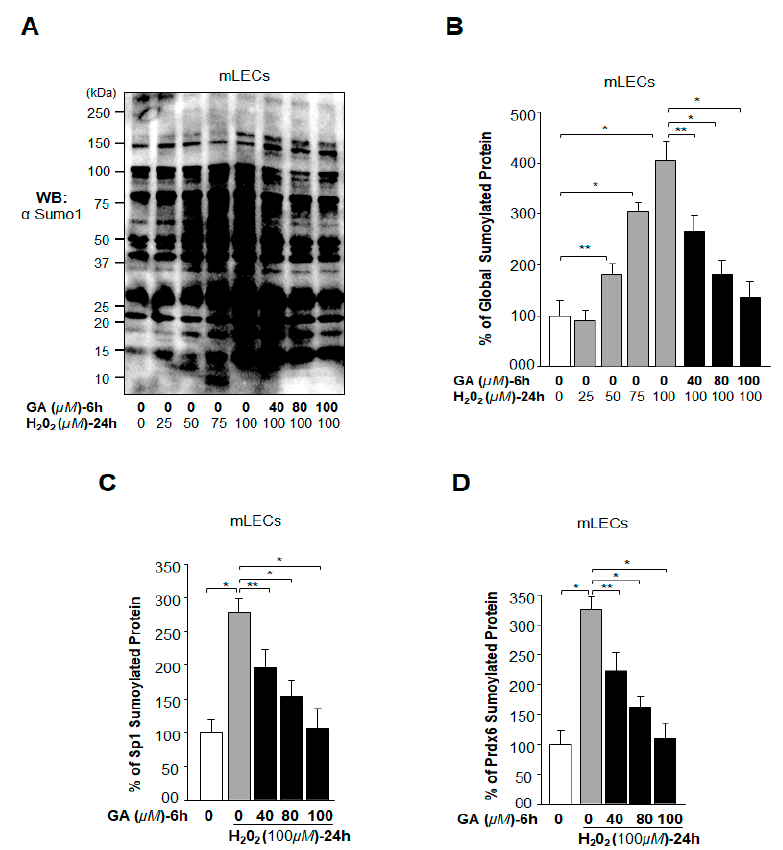
Figure 5. GA application reversed oxidative stress-induced aberrant Sumoylation of proteins in vivo. ( A , B ) mLECs were treated with DMSO control or different concentrations of GA for 6 h, and then cells were washed and exposed to H 2 O 2 as indicated. Total protein was isolated from mLECs treated with GA and/or H 2 O 2 . Samples that had equal amounts of protein content were immunoblotted ( A ) with an anti-Sumo1 antibody. The same protein lysate was used for a Sumo1 ELISA assay to quantitate the level of global protein Sumoylation using an anti-Sumo1 antibody as shown. ( C , D ) GA treatment reversed the aberrant Sumoylation of Sp1 and Prdx6 induced by oxidative stress. mLECs pretreated with DMSO or GA were exposed to H 2 O 2 as indicated. Cell lysate with an equal amount of protein was used for Sumo1-ELISA assay to quantify the level of Sp1 ( C ) and Prdx6 ( D ) protein Sumoylation, using anti-Sp1 or anti-Prdx6 antibodies, respectively. The data represent the mean ± SD from three independent experiments. Control (open bar) vs. H 2 O 2 (gray bar) treated and pretreated with DMSO vs. GA (black bars) in the presence of H 2 O 2 . ** p < 0.05; * p < 0.001.